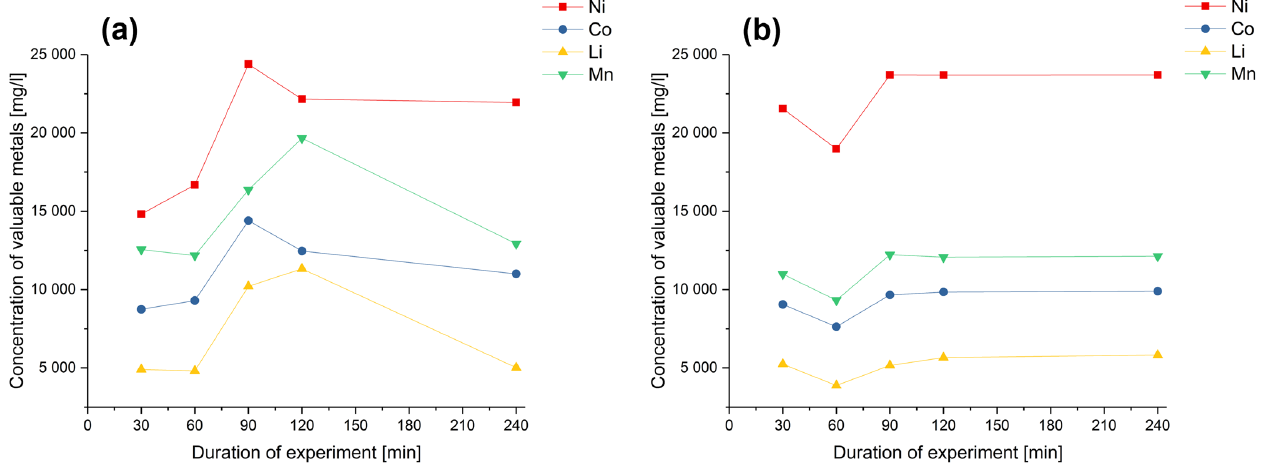
Figure 12. Concentration curve of Ni, Co, Li and Mn in the leaching solutions as a function of the leaching time in comparison with the results at ( a ) 0% and ( b ) 20% Si met and SiO 2 (in total) with otherwise constant parameters (5 mol/L H 2 SO 4 , 80 °C, 100 g/L solids, 0% H 2 O 2 ).